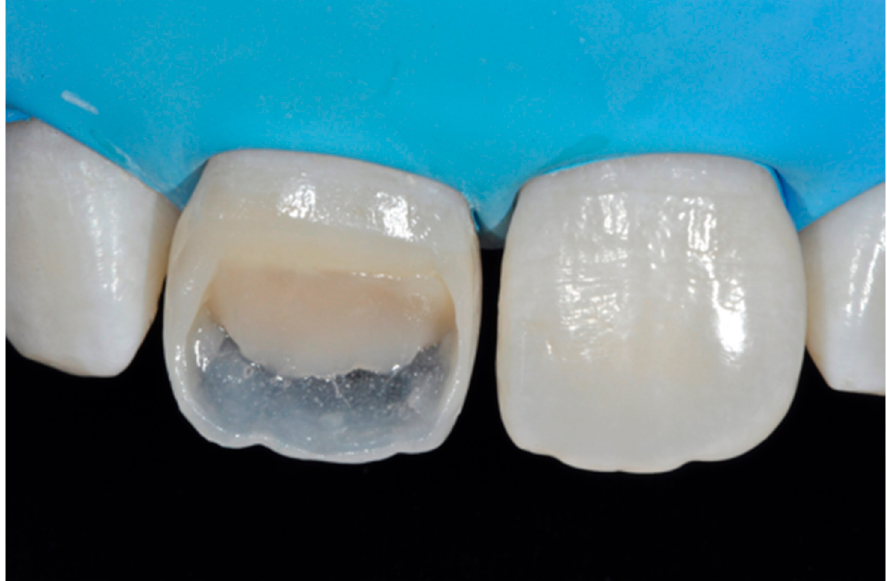
Figure 10. First increment of the dentinal body. Reprinted from Restauri diretti nei settori anteriori, G. Paolone, S. Scolavino, © 2021, with permission from Quintessence Publishing Italy.